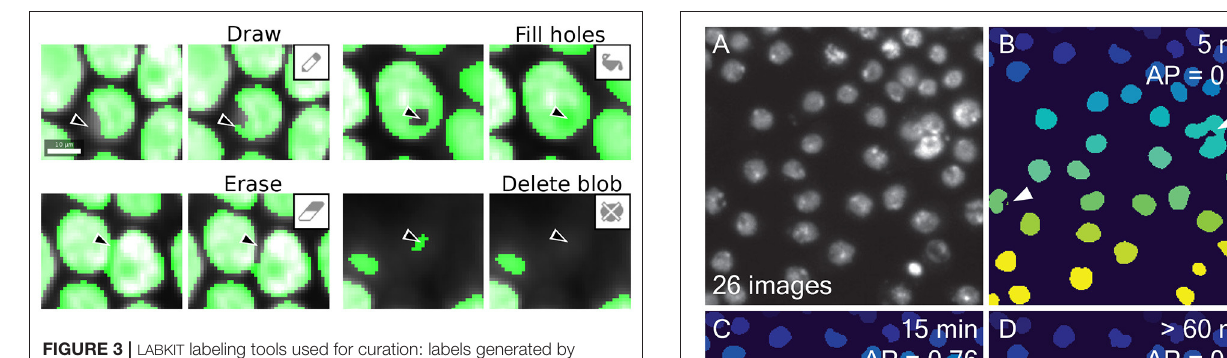
FIGURE 3 | LABKIT labeling tools used for curation: labels generated by manual dense labeling or automatic segmentation can be efficiently curated with drawing, filling, erasing, or deletion of entire objects. Scale bar 10 µ m.